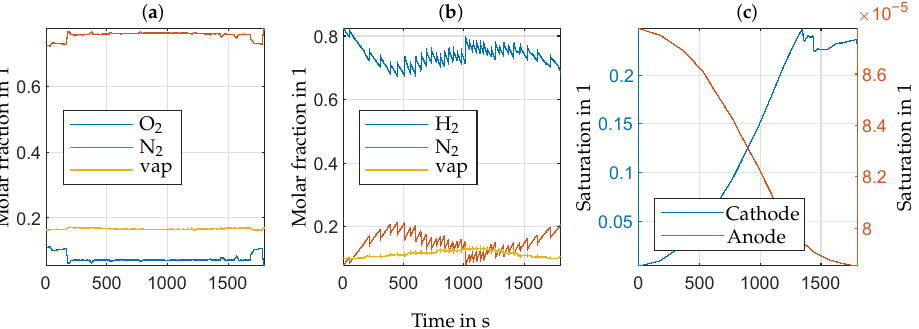
Figure 4. Simulated internal species of cathode ( a ) and anode ( b ) in molar fractions and liquid water in terms of saturation ( c ).